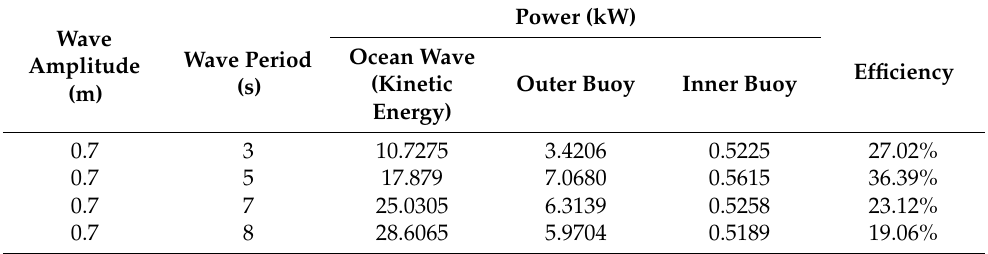
Table 2. The theoretical conversion efficiency from ocean wave power into the buoy’s power. Wave